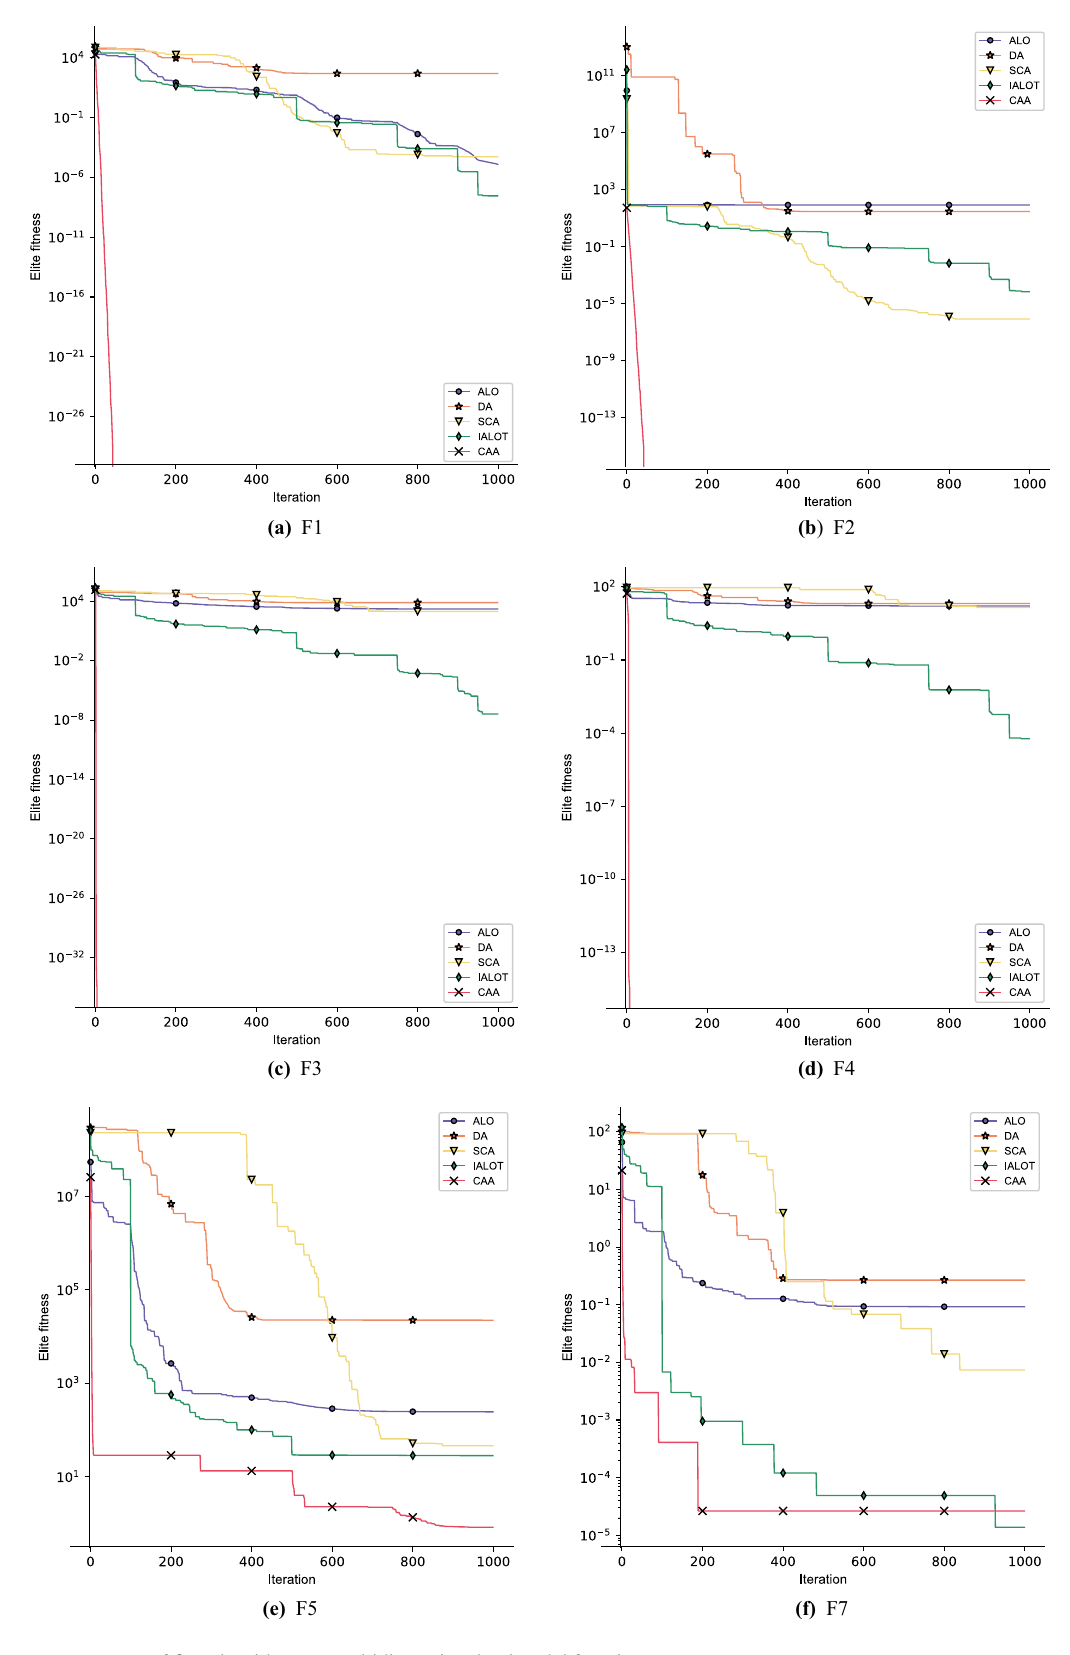
Fig. 8 Convergence curve of five algorithms on multidimensional unimodal